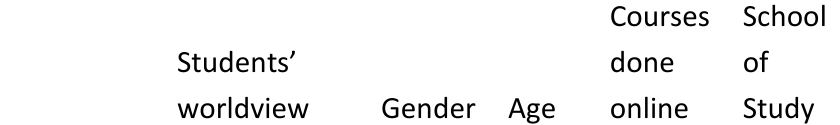
Table 4. Correlation analysis on students' demographics' influences